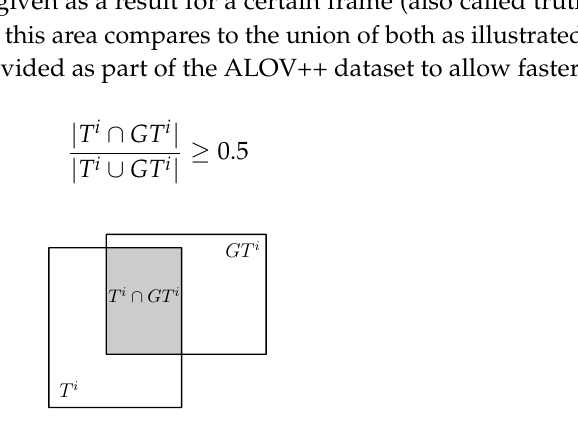
Figure 6. T i (truth) and GT i (ground truth) may intersect. The PASCAL criterion helps to quantify how similar T i and GT i are, based on